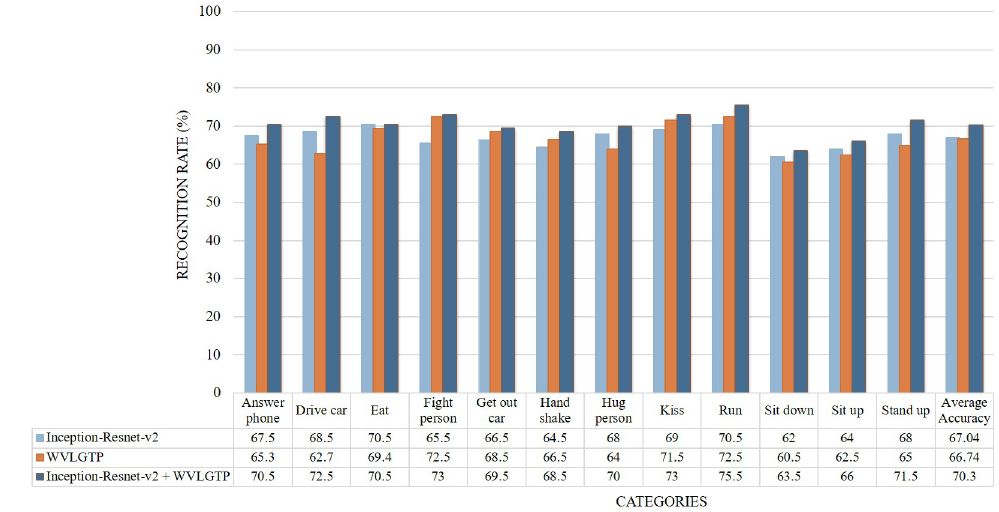
Figure 14. Accuracy comparison of each class by Inception-Resnet-v2, WVLGTP, and Inception-Resnet-v2 plus WVLGTP on the Hollywood2 dataset.